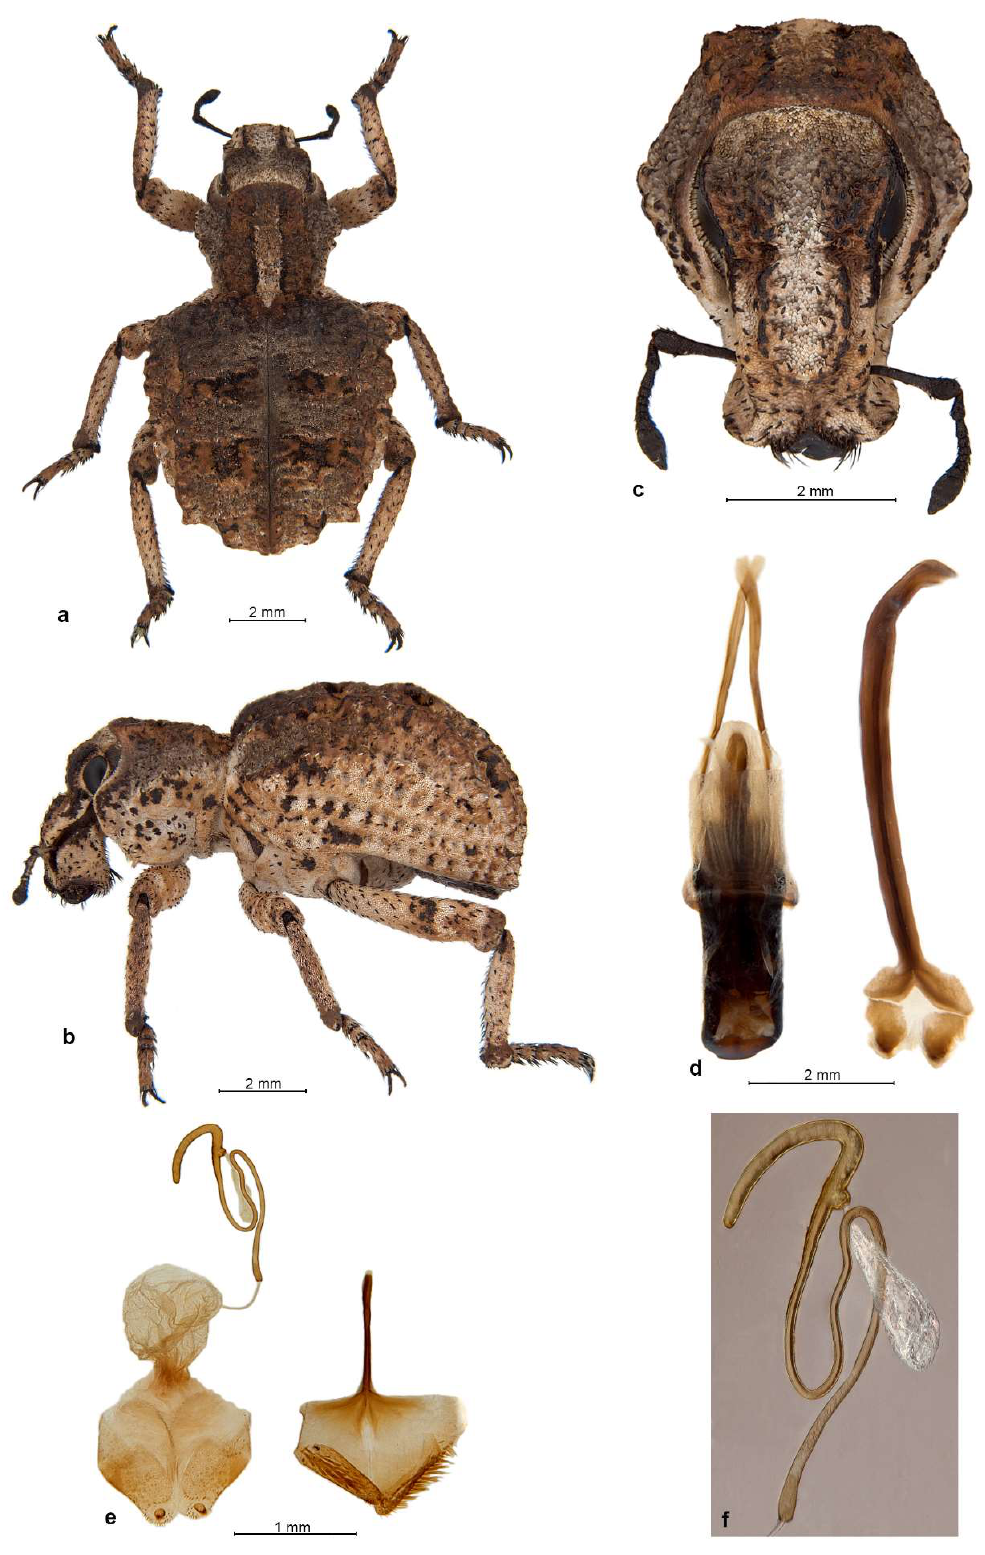
Figure 11. Spartecerus umbrinus Fåhraeus (South Africa, 5 km S Barkley West, 02.ii.1985, ab larva feeding on underground stem of Bulbine cf. narcissifolia , R. Oberprieler), habitus and genitalia. ♀ , dorsal habitus ( a ); ♀ , lateral habitus ( b ); ♀ , head, frontal view ( c ); ♂ , aedeagus and sternite IX, dorsal view ( d ); ♀ , terminalia, dorsal view ( e ); spermatheca with gland, ventral view ( f ).